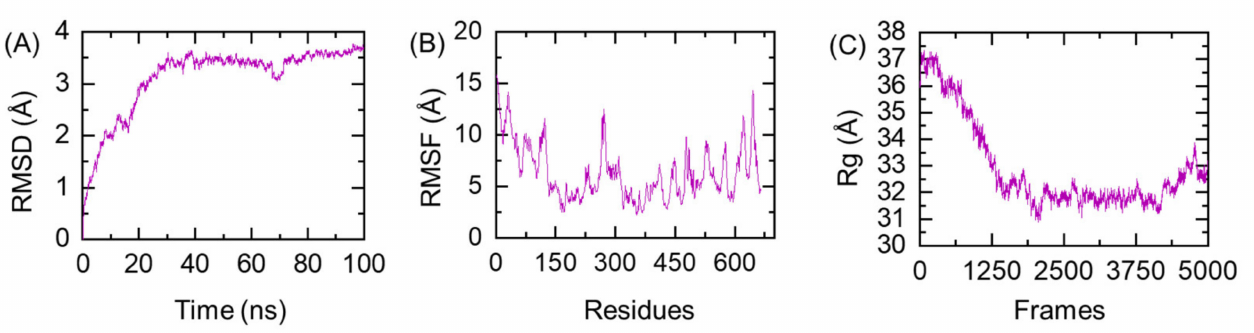
Figure 5. Graphical depiction of the vaccine secondary structure. Each secondary structure element is represented by a different symbol given above each region.